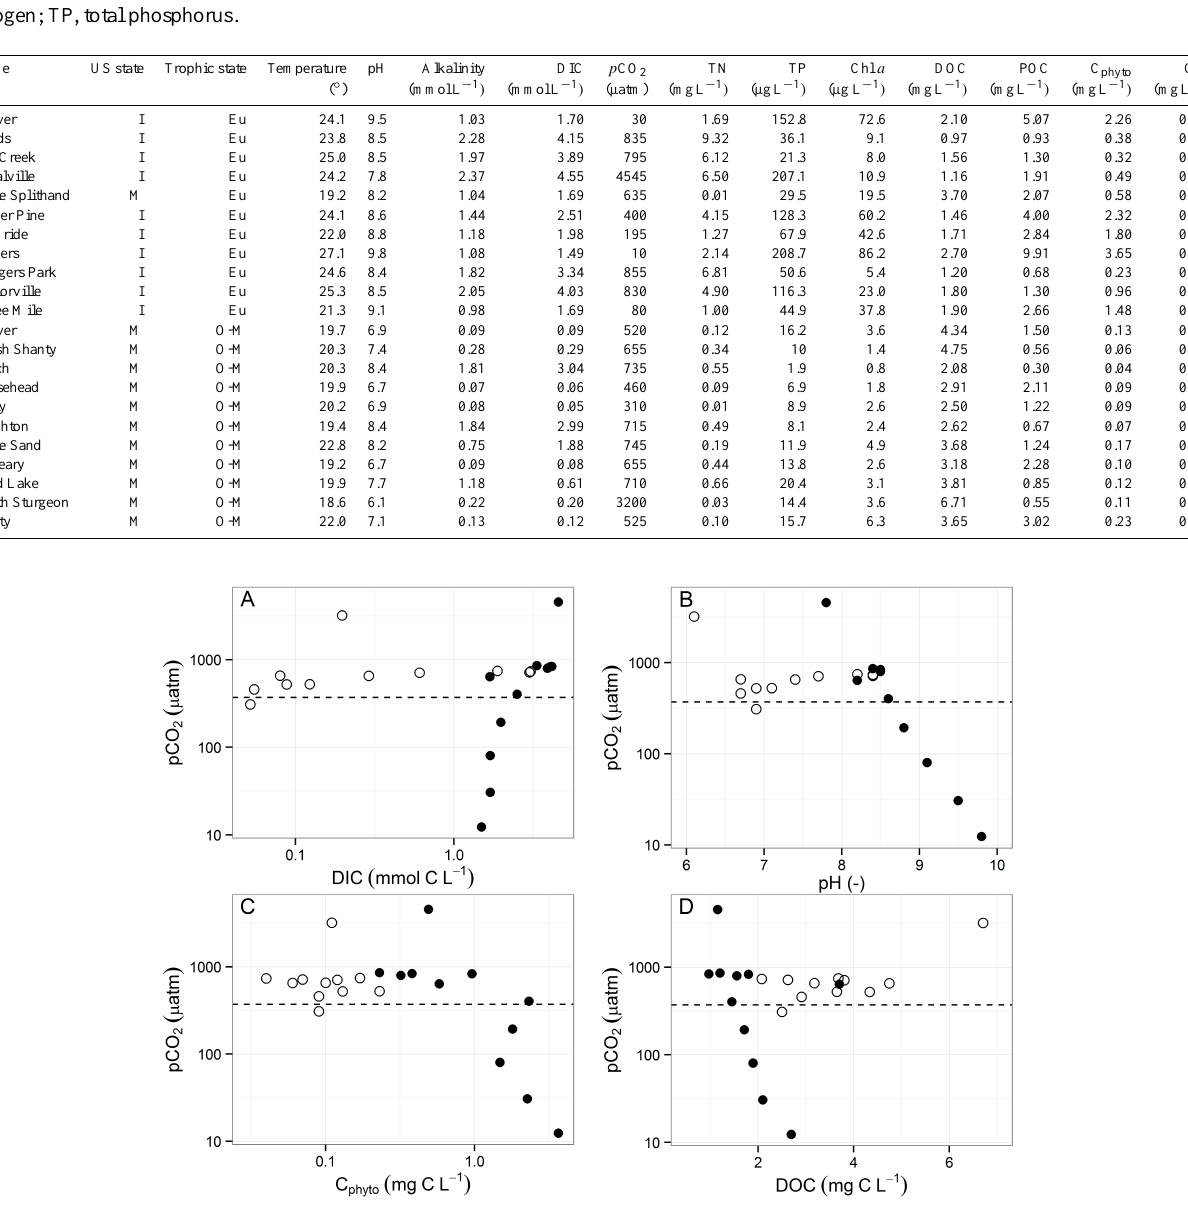
Figure 1. The relation of p CO 2 in eutrophic lakes (filled circles, n = 11) and oligo-mesotrophic lakes (open circles, n = 11) to (a) DIC; (b) pH; (c) C phyto ; (d) DOC. The dashed line indicates atmospheric p CO 2